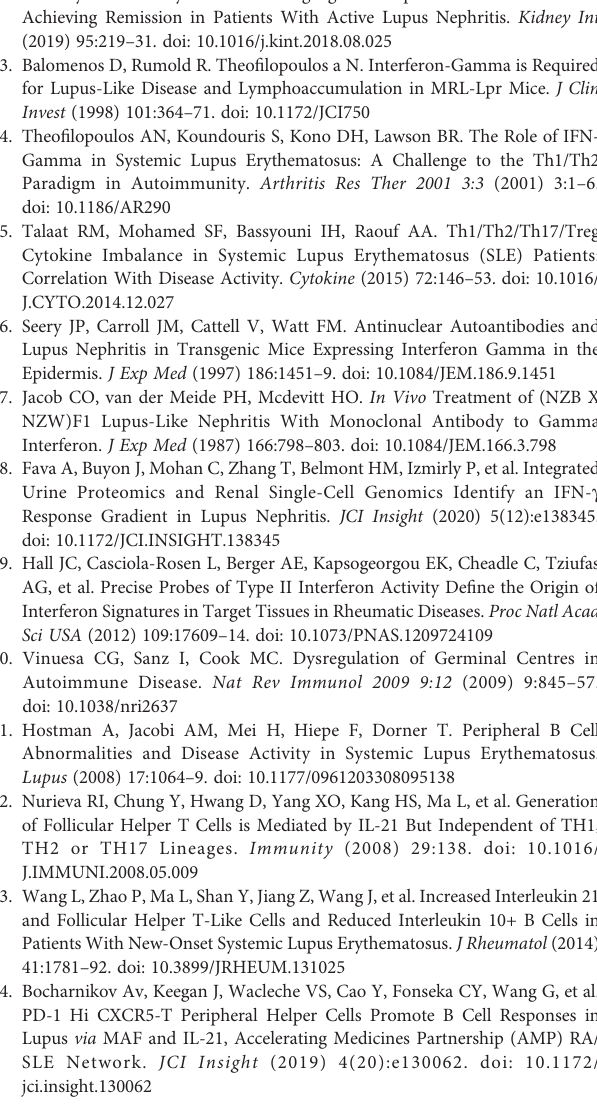
represents effect size of IFN signature (IFN-H v. IFN-L patients, right) or (B) SLE (left), on intraceullar protein production (columns) across cell subsets (rows) after stimulation with PMA and ionomycin. Dot size depicts effect size, larger dots have greater effect sizes. Color depicts direction of effect size, red indicates positive effect size and blue indicates negative effect size. Shading of each box depicts statistical signi fi cance by -log10(FDR), darker boxes indicate greater statistical signi fi cance. Only cell populations with FDR < 0.05 are displayed in the dotmaps. (D) Forest plots representing the effect size of IFN signature (IFN-H v. IFN-L) on phosphylation of pSTAT5 downstream of IFN a (left), IFN g (middle), or IL-21 (right) stimulation. Signi fi cant (p<0.05) effect sizes in red and not signi fi cant effect sizes in black. P values were adjusted using Benjamini-Hochberg false discovery rate (FDR). Supplementary Figure 4 | (related to Figure 6): Histograms displaying expression of both surface (CD19, CD24, CD27, and CD127) and intracellular signaling (pSTAT1, pSTAT3, pSTAT5, pERK, IKB, pS6, and pPLCg2) proteins of manually gated T cells expressing pSTAT1 and 3, pSTAT1, pSTAT3, or DN = double negative T cells, from HC, IFN-L or IFN-H PBMCs stimulated with IFN a , IFN g , IL-21 or unstimulated